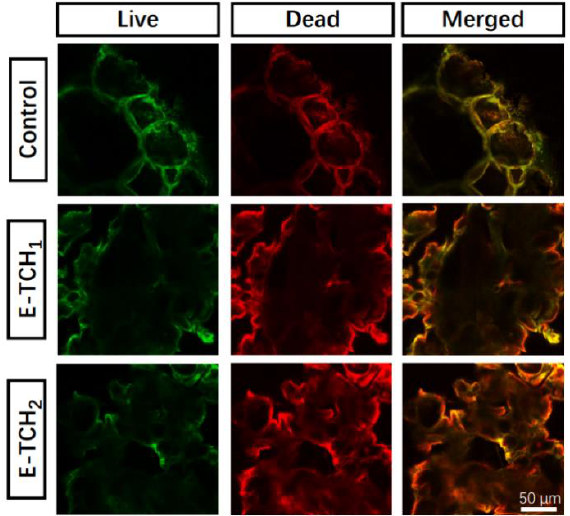
Figure 7. Live and dead staining of S. aureus cultured on different scaffolds for 4 h.